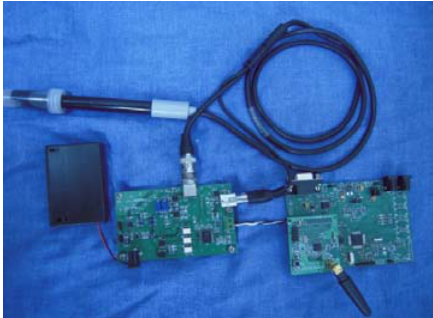
Figure 21. Actual data monitoring node.